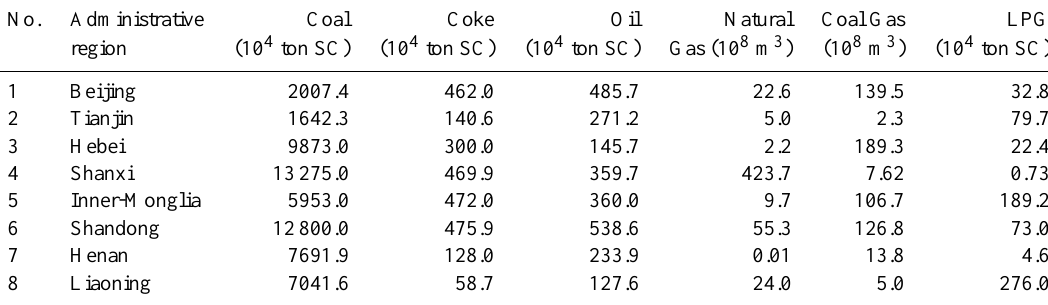
Table 2. Annual energy use in the larger Huabei region in 2003.